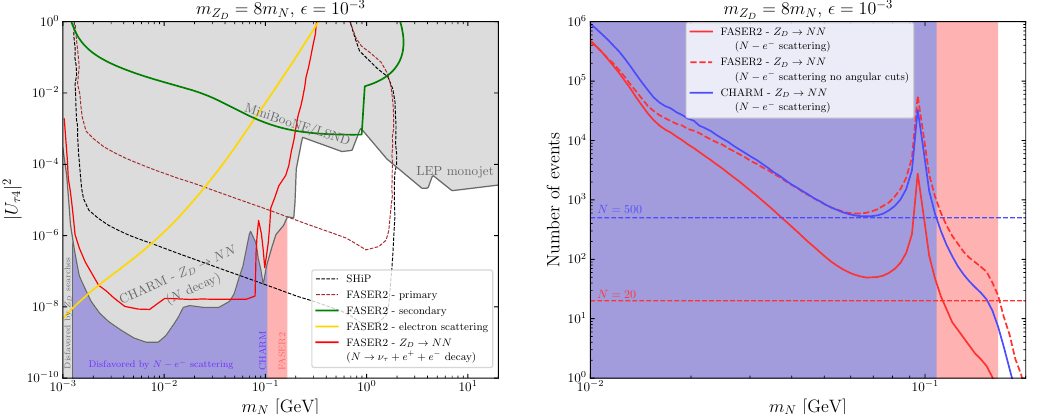
= 8 m , Figure 4 . The results for the model with the dark gauge boson heavier than the HNL, m Z N D and with the dominant mixing between the HNLs and active tau neutrinos, U . The kinetic mixing τN parameter in the plots is also fixed to be equal to (cid:15) = 10 − 3 . Left : the FASER 2 and SHiP sensitivity in the ( m ) plane. The dashed red and blue lines for both the experiments, respectively, are N , U τN shown following ref. [39]. The additional FASER 2 sensitivity due to the secondary production of the HNL is shown with the green solid line. The red solid line corresponds to the additional FASER 2 reach due to the possible production of the HNLs in the dark gauge boson decays, Z . D → NN The yellow solid line is the expected exclusion bound relevant for the search for inelastic, νe → Ne , and elastic, Ne → Ne , scatterings off electrons, assuming that in the latter case the HNLs are produced due to the mixing with the active neutrinos. The relevant results for FASER 2 for the HNLs produced in the Z decays are shown with the red-shaded region, while the past bounds D from the CHARM-II experiments are indicated with the blue-shaded region. Right : the expected number of elastic scattering events, Ne → Ne , in the CHARM-II (blue solid line) and FASER 2 (red solid line) that take into account the relevant cuts for the electron recoil energy and angle. The red dashed line corresponds to the expected events in FASER 2 after the recoil angle cuts have been relaxed. The dashed horizontal lines correspond to N = 20 (red) or 500 (blue) events, and ev are used to set the CHARM-II and FASER 2 bounds (see the text for